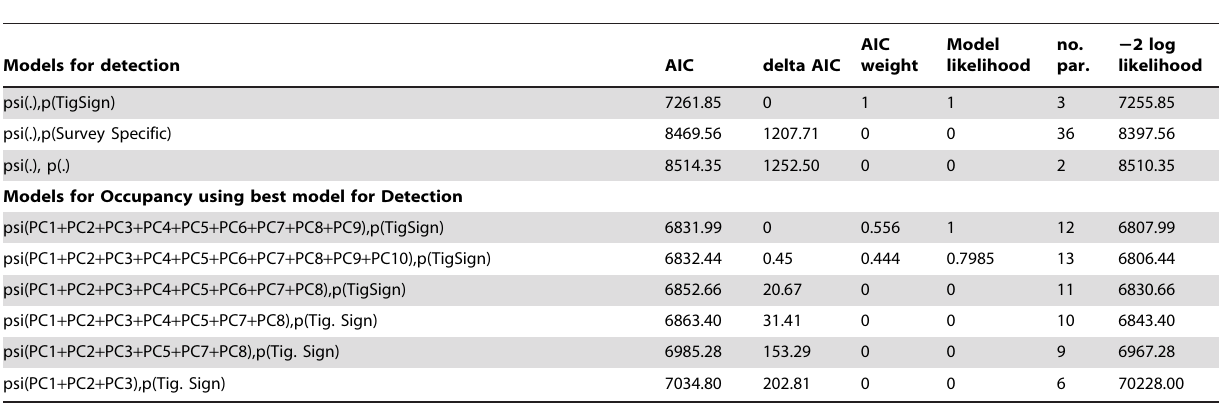
Table 8. Model selection results for estimating tiger occupancy within the Central Indian Landscape incorporating imperfect detections and covariates of landscape characteristics, prey abundance, and human disturbance represented by 10 Principal Components.